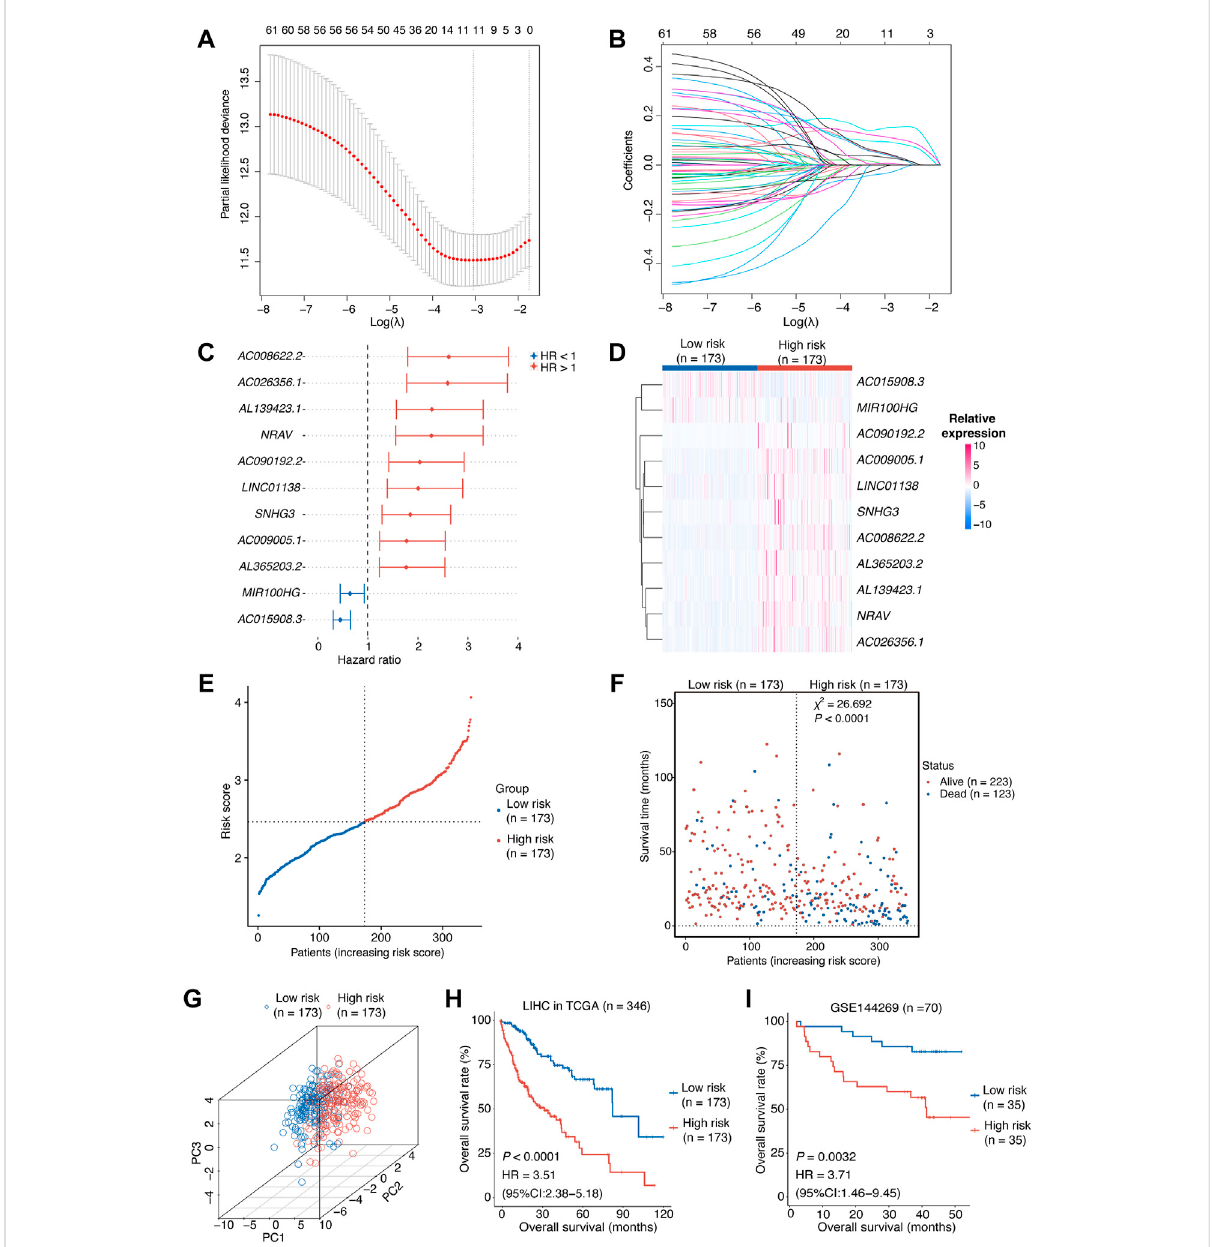
FIGURE 2 Construction of the risk score model. (A,B) OIS-related lncRNA candidates for constructing the prognostic model (obtained 11 non-zero coef fi cients fromLASSO-Coxregressionanalysis). (C) TheHRsand95%CIsofthe11optimalOIS-relatedprognosticlncRNAsidenti fi edbyCoxregressionanalysis. (D) A heatmapofexpressionlevelsofthe11lncRNAsintheriskscoremodel. (E) TherankofHCCpatientsaccordingtotheriskscore. (F) Thecorrelationbetween the HCC patients ’ prognosis and the risk score. The p value was computed using χ 2 test. (G) A three-dimensional scatter PCA plot of HCC patients according to the risk score. (H) Kaplan-Meier survival plots of HCC patients from the training cohort (HCC tumors from TCGA) with a highor low risk score accordingtothe11-OIS-related-lncRNAprognosticriskmodel. (I) Kaplan-MeiersurvivalplotsofHCCpatientsfromthevalidationcohort(GSE144269)witha highorlowriskscoreaccordingtothe11-OIS-related-lncRNAprognosticriskmodel.OIS,oncogene-inducedsenescence;HR,hazardsratio;CI,con fi dence interval; HCC, hepatocellular carcinoma; PCA, principal component analysis; TCGA, the cancer genome